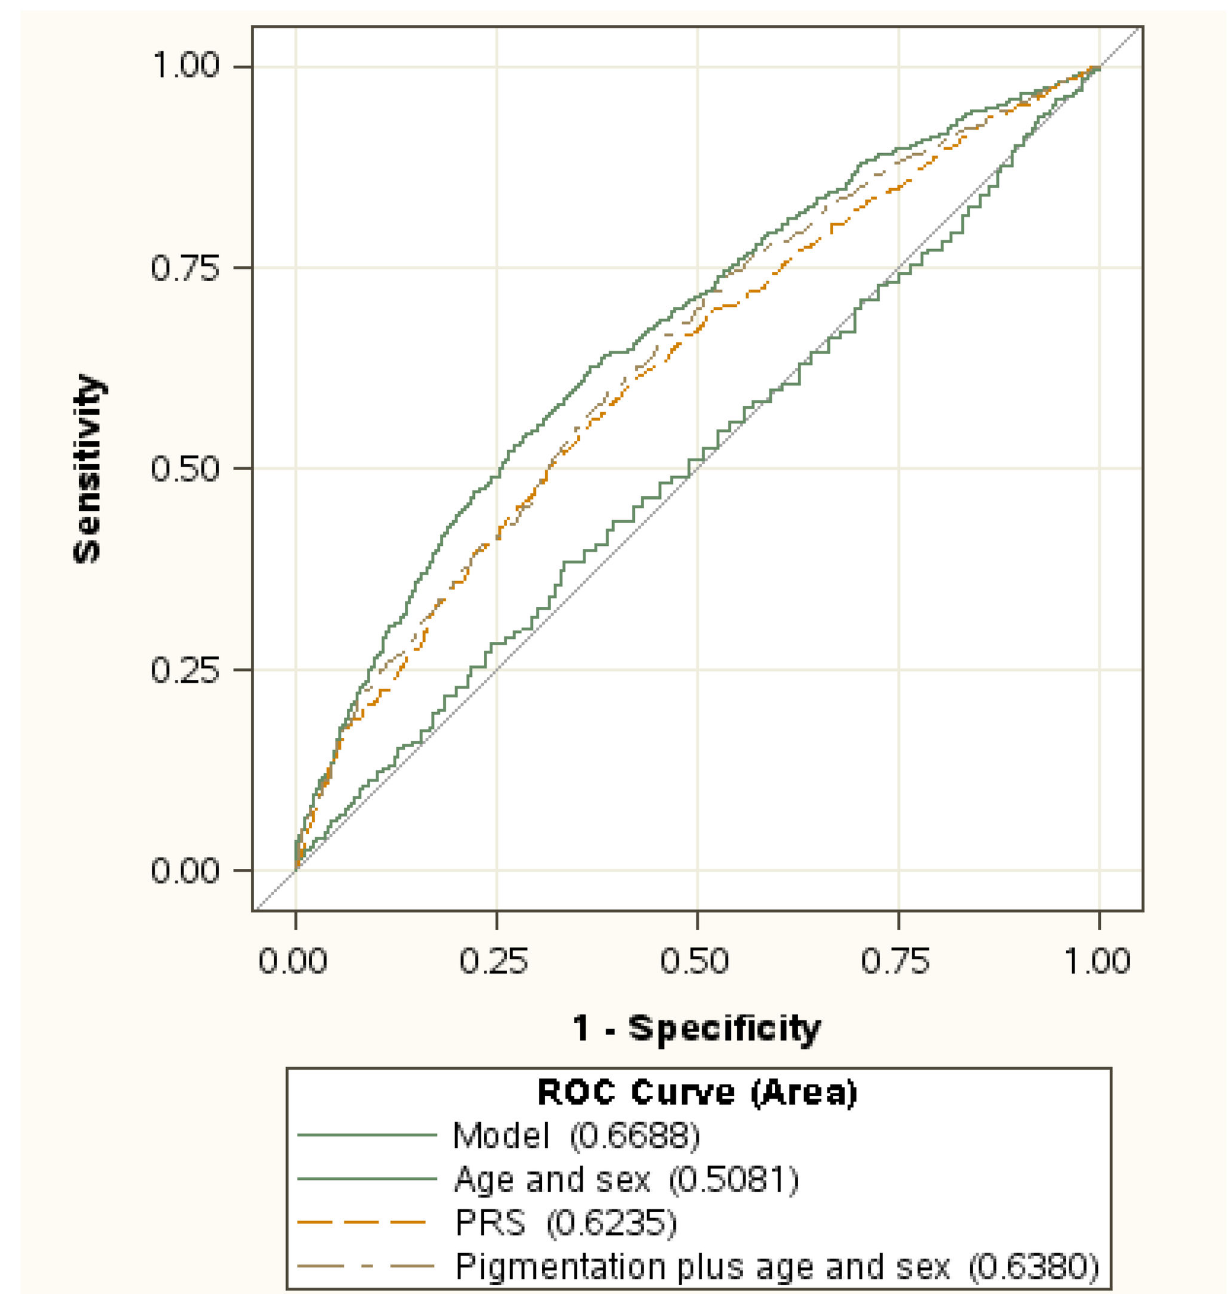
Figure 1. Receiver operating characteristic (ROC) curve for prediction of melanoma risk based on age and sex; pigmentation, age, and sex; polygenic risk score (PRS); and PRS plus pigmentation, age, and sex(model).